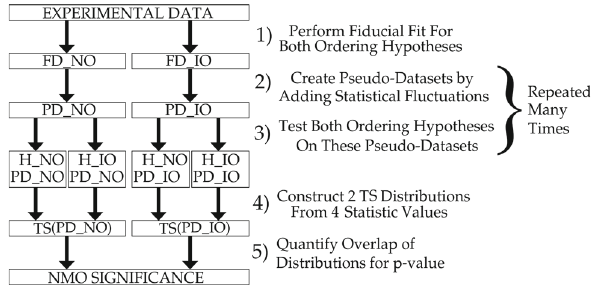
Fig. 7 Flow-chartrepresentingtheprocedureofthefrequentistmethod used to derive p -values for the NO and IO hypotheses. Abbreviations, as defined in the text, are FD (fiducial fits), PD (pseudo-dataset), H (hypothesis), and TS (test statistic)